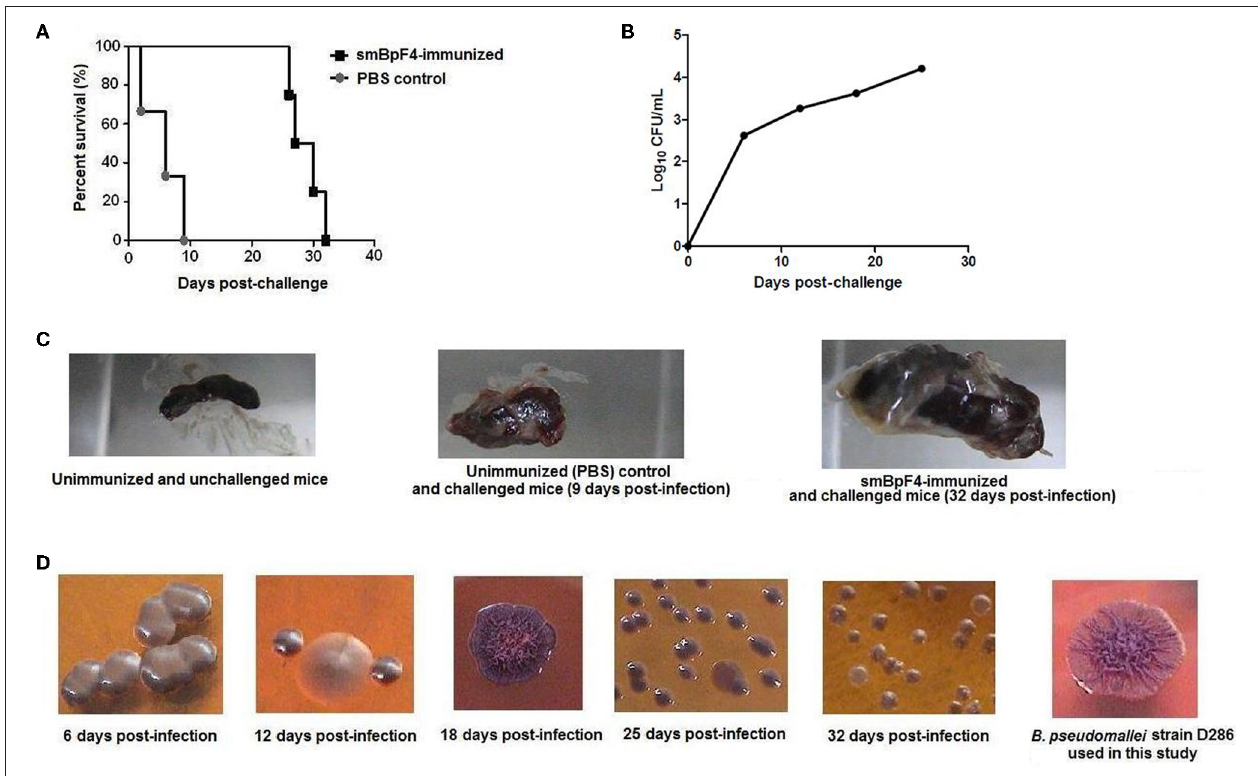
FIGURE 4 | Survival and assessment of bacterial burden of recombinant smBpF4-immunized mice against lethal challenge with 1 × 10 6 CFU B. pseudomallei D286 by the i.p. route of infection. (A) Mice were immunized with smBpF4 (black squares) prior to challenge with B. pseudomallei D286. All the smBpF4-immunized mice (black squares) survived up to or beyond 25 days post-infection. All the PBS-treated control mice (grey circles) died by day-9 post-challenge. (B) Bacterial loads in the blood of smBpF4-immunizedand challenged mice over the 25 days